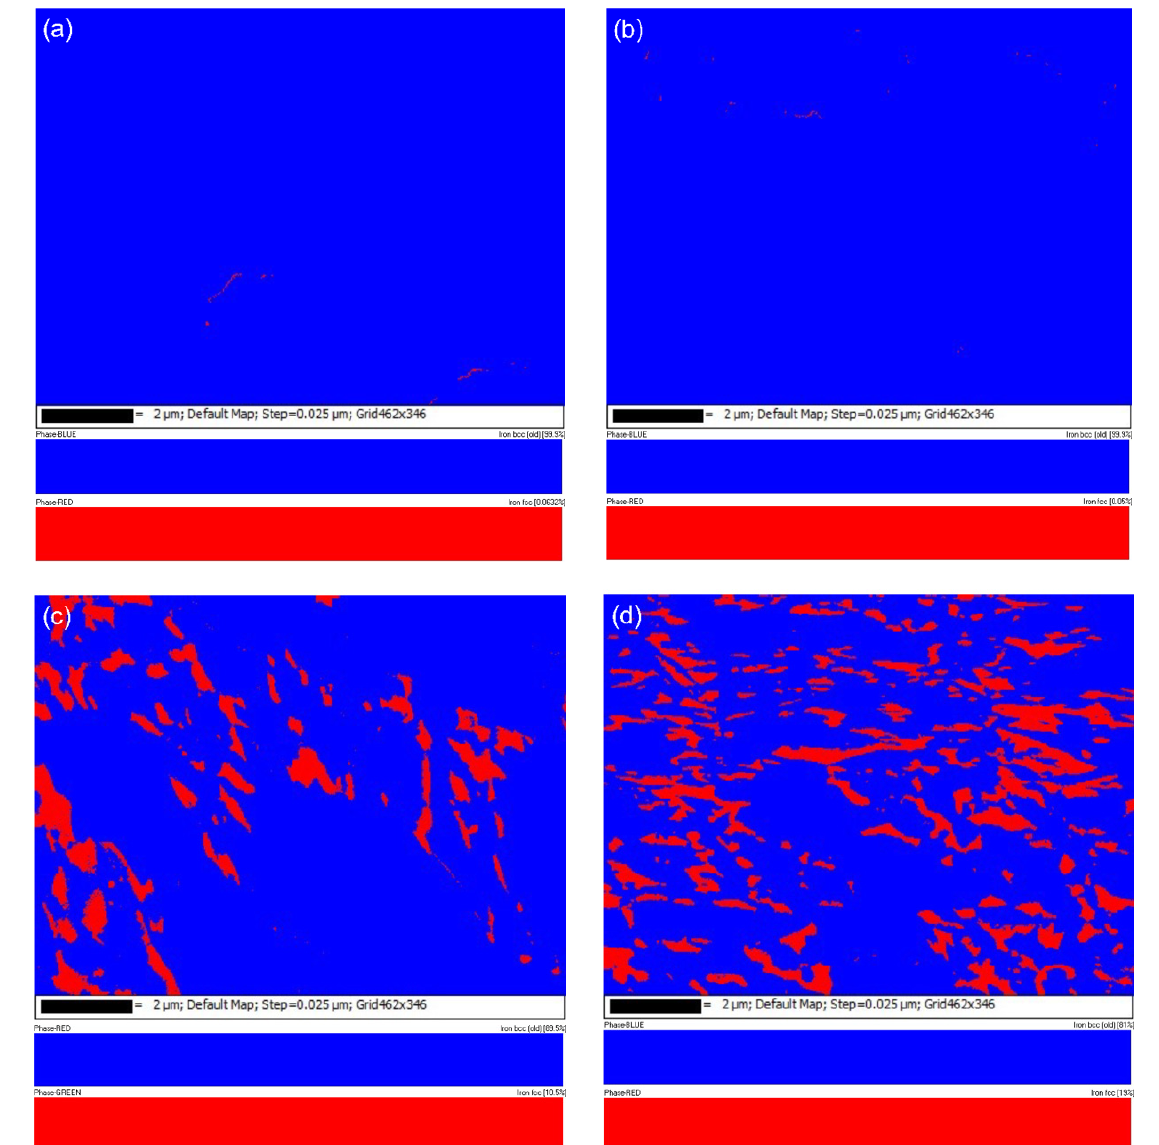
Figure 7. EBSD phase maps of Group 3. ( a ) BM, ( b ) HAZ, ( c ) TMAZ, ( d ) CWZ.